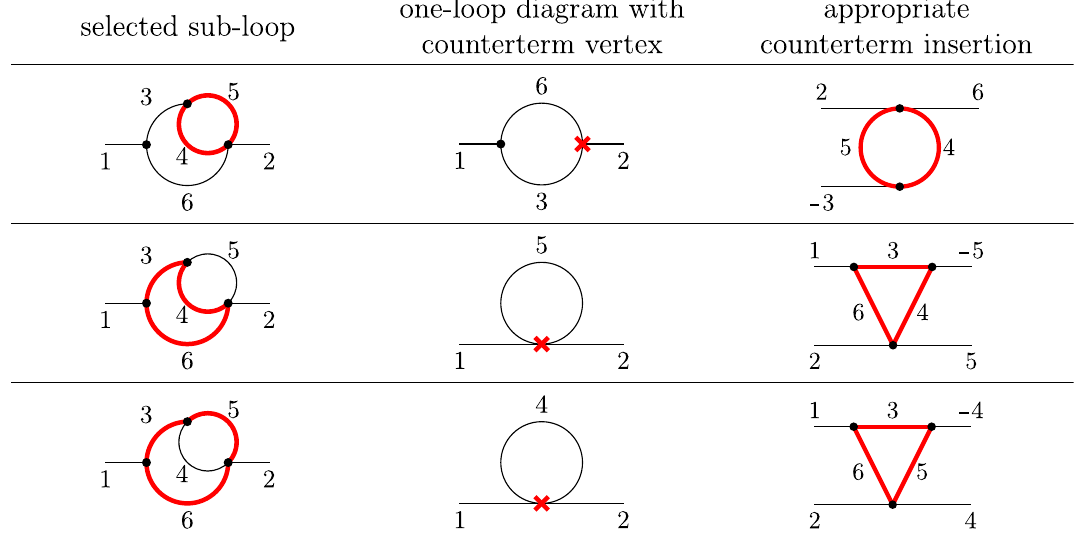
The consecutive numbers at the lines label the propagators; the same number in the diagrams of one row refers to the same particle at that propagator. A signed number indicates the antiparticle to the unsigned one (note that external particles are defined as incoming by